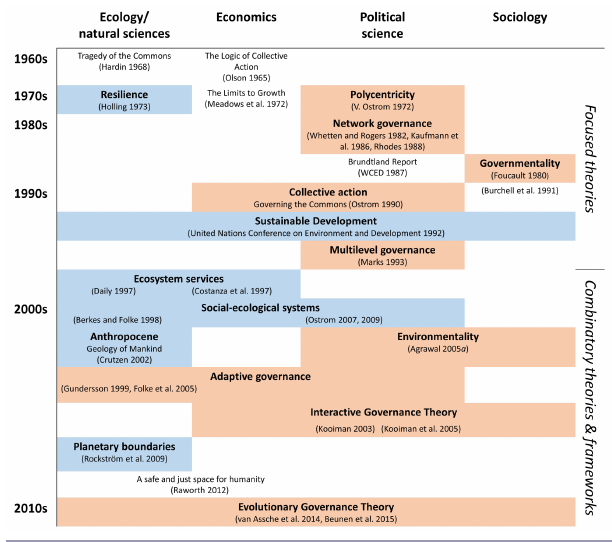
Fig. 3 . Simplified heuristic conceptualization of the disciplinary origins of environmental governance theories (orange) and related concepts (blue) since the 1960s. Selected influential literature references are also